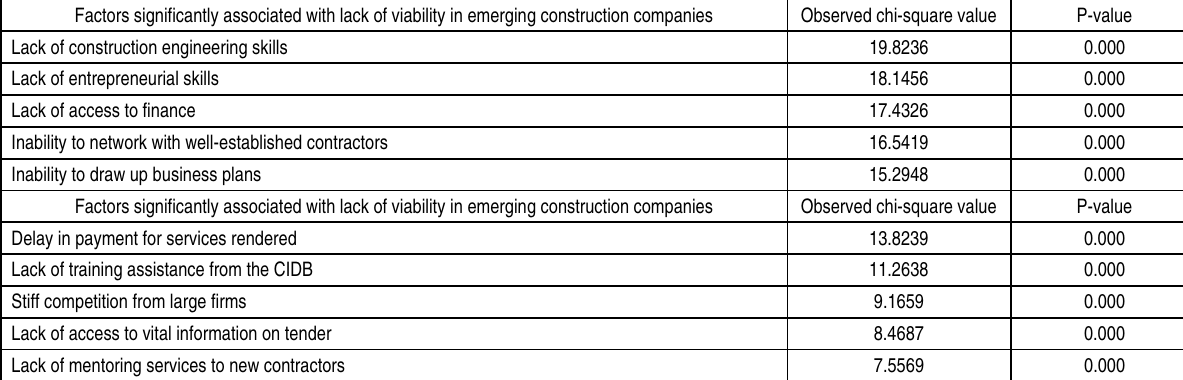
Table 3. Barriers to viability in emerging construction companies